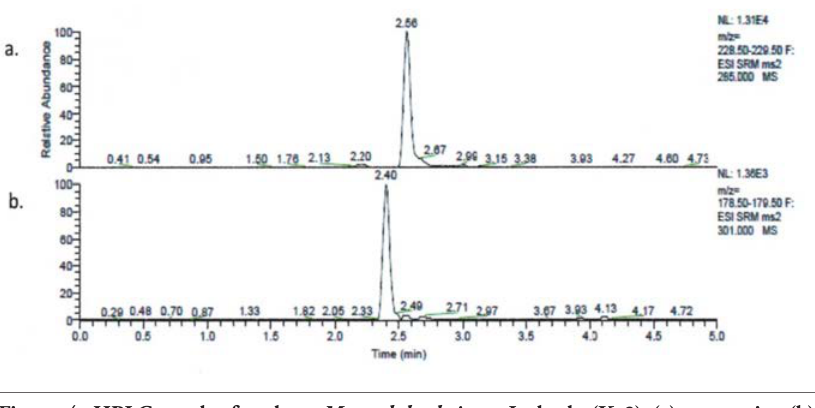
Figure 4. HPLC results for three M. malabathricum L. buds (K 3) (a) quercetin, (b) kaempferol.